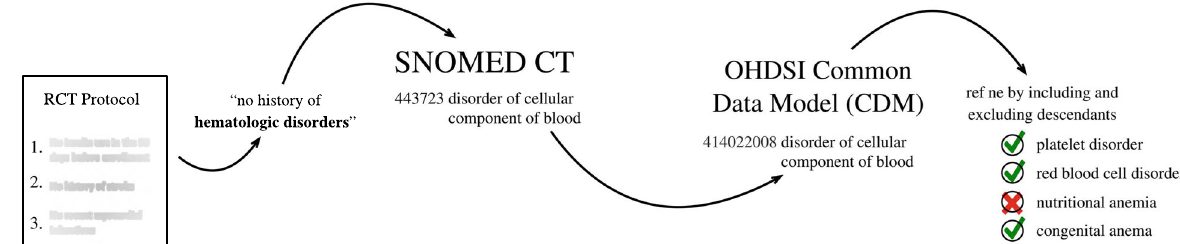
Fig. 2 Pipeline to operationalize eligibility criteria using OHDSI tools. The process begins by identifying the resources (e.g., an RCT protocol) that detail the eligibility criteria of a trial. Each criterion is then extracted and mapped to codi fi ed concepts in a controlled vocabulary. The concept is then mapped to the OHDSI common data model (CDM), which aggregates the same concepts from different vocabularies, into a single standardized concept. This concept is then re fi ned to best de fi ne the eligibility